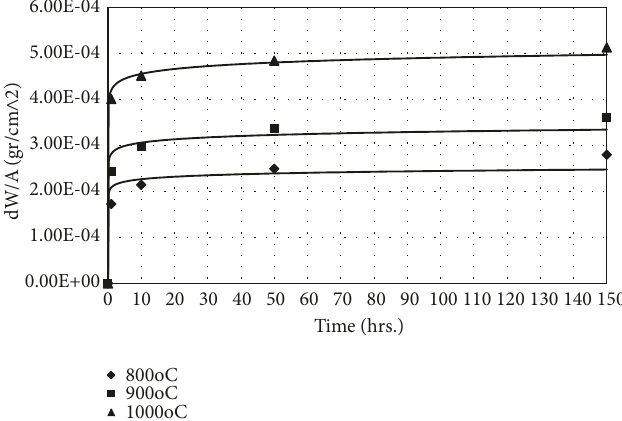
Figure 10: Weight change of samples oxidized at different temperatures and